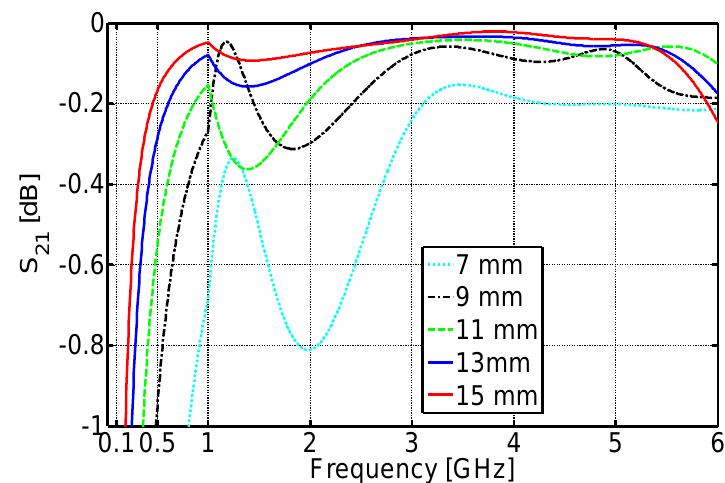
Figure 7. Detailed simulation of gap transmission characteristics (depending on flange radius R ’) in frequency and amplitude values of interest (gaps filled with acetal homopolymer) .